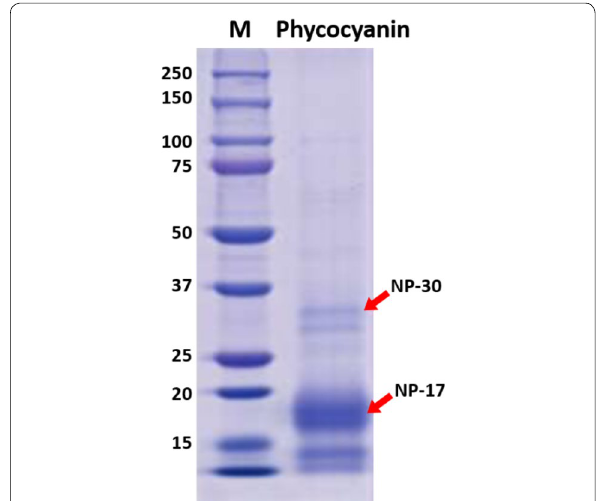
Fig. 1 Identification protein expression of natural products from